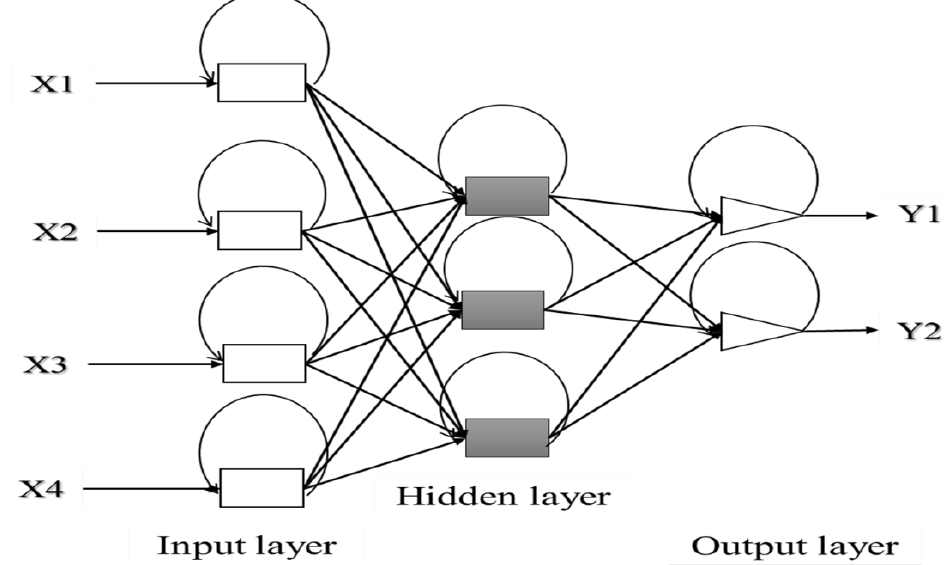
Figure 6. Feedback network structure. Adapted from Agatonovic-Kustrin and Beresford[138].